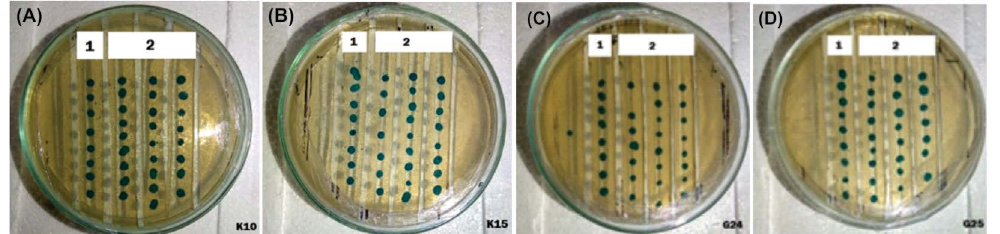
Fig. 2. AHL inactivation test using biosensor agent Agrobacterium tumefaciens NT1 (tra::lacZ749) towards Lactic Acid Bacteria isolates from kefir and kefir grain : K10 (A), K15 (B) G24 (C), and G25 (D),. There is no colour change in A. tumefaciens colonies supplemented with LAB (1) as well as without LAB (2).